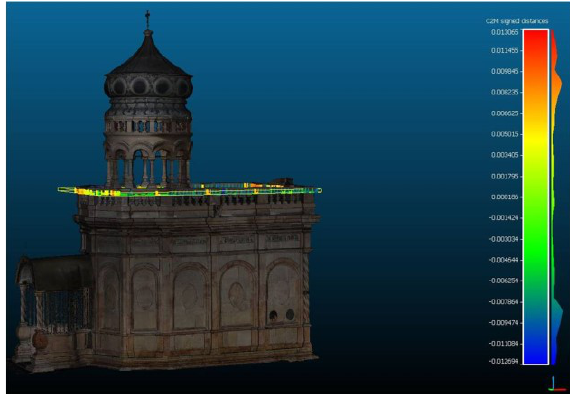
Figure 10 . The 1 st horizontal section and its deviations from the reference surface